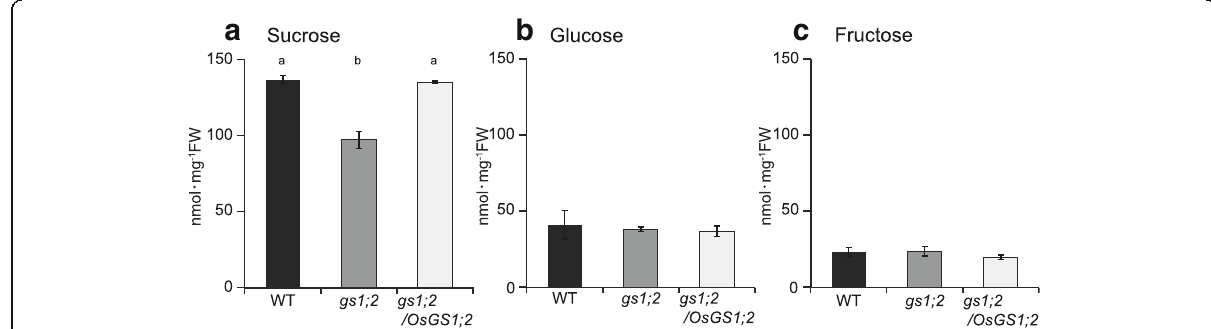
Fig. 2 Content of sucrose ( a ), glucose ( b ), and fructose ( c ) in the basal portions of shoots. Wild-type rice (WT: black column), gs1;2 mutants ( gs1;2 : gray column), and gs1;2/OsGS1;2 complementation line ( gs1;2/OsGS1;2 : open column) were grown hydroponically in the presence of 1 mM NH 4 Cl until the fourth leaf stage. Mean values plus the SE of five independent plants are indicated. Different letters at the top of each column denote statistically significant differences in metabolite levels among the WT, gs1;2 , and gs1;2/OsGS1;2 seedlings ( P < 0.05 according to one-way ANOVA followed by the Bonferroni